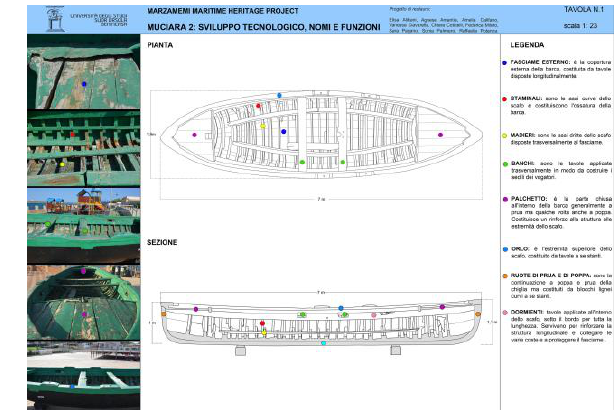
Figure 11. Graphics for the restoration project of a ‘muciara ’ in